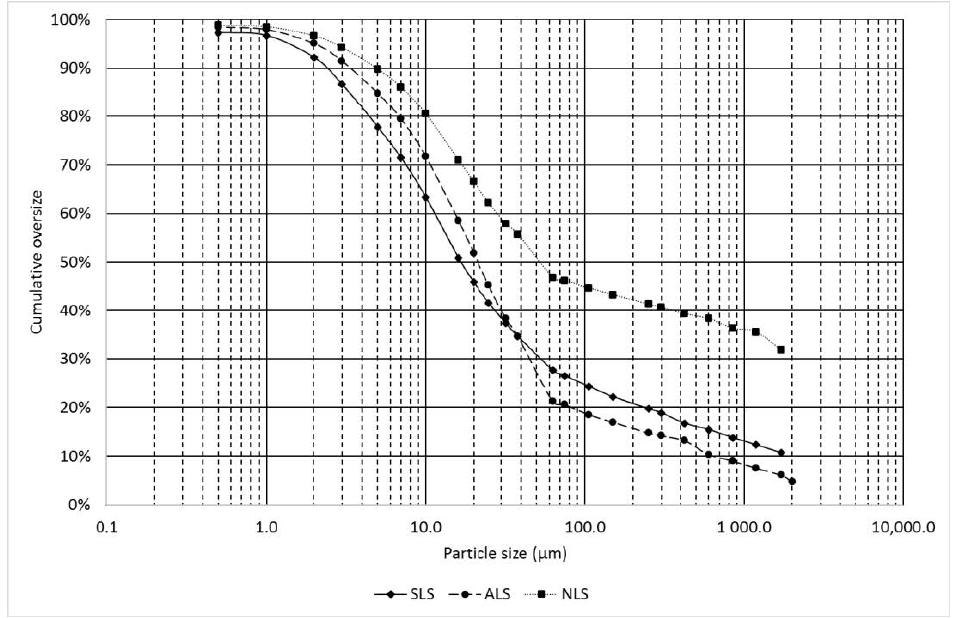
Figure 7. Particle size distribution of each sediment